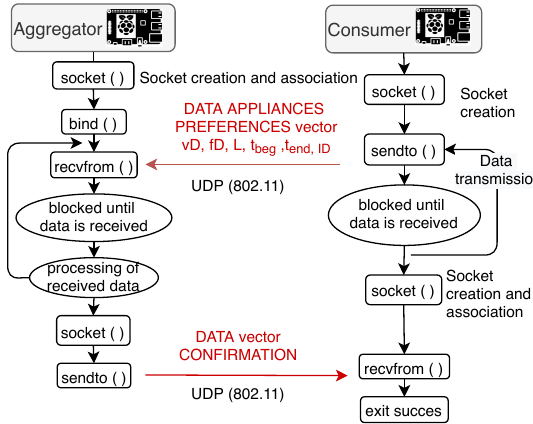
Figure 10. Consumer– aggregator UDP communication.